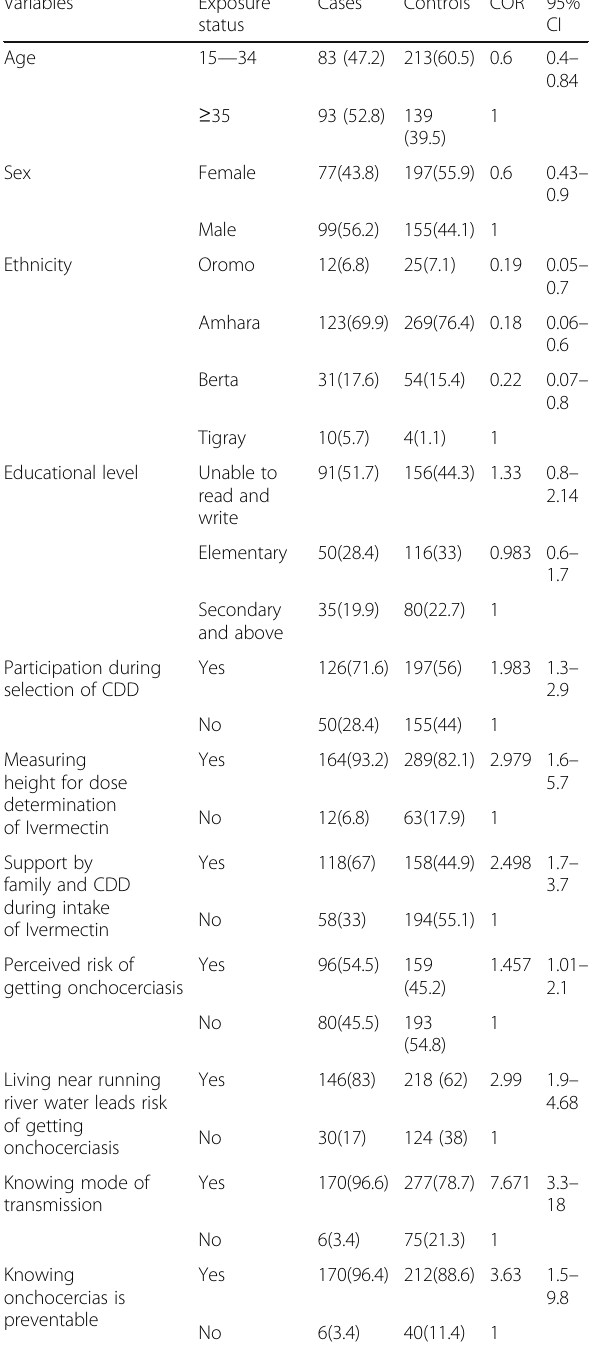
Table 1: Background characteristics of respondents and bi- variable analysis in Assosa district, Western Ethiopia,